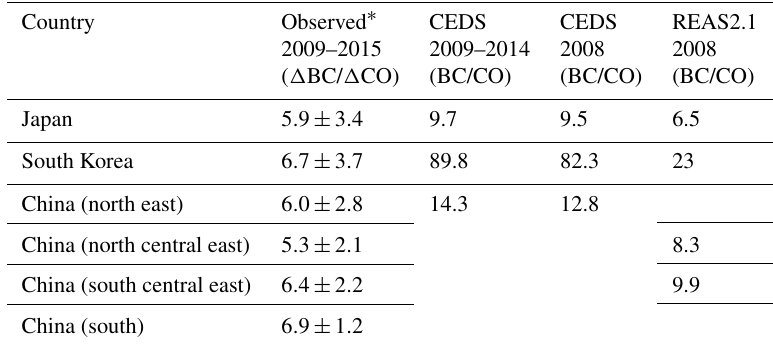
Table 8. Observed and inventory BC / CO emission